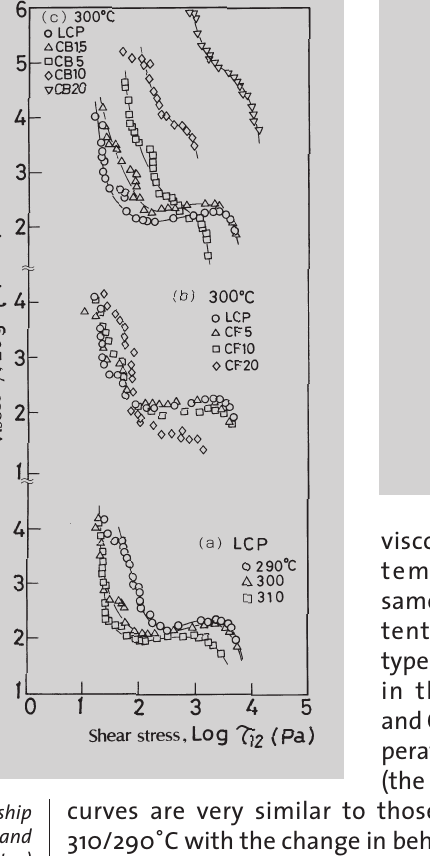
Figure 5 (left): Relationship between viscosity h and shear stress t 12 of LCP at a.) various temperatures, b.) various filling levels of car- bon fiber (CF), and c.) carbon black (CB), (all at 300˚C). Figure 6 (right): Casson plots: relationship between shear stress, t 121/2, and shear rate, g · 1/2, of pure LCP, carbon fiber (CF20), and car- bon black (CB20) com- pounds at 300˚C.